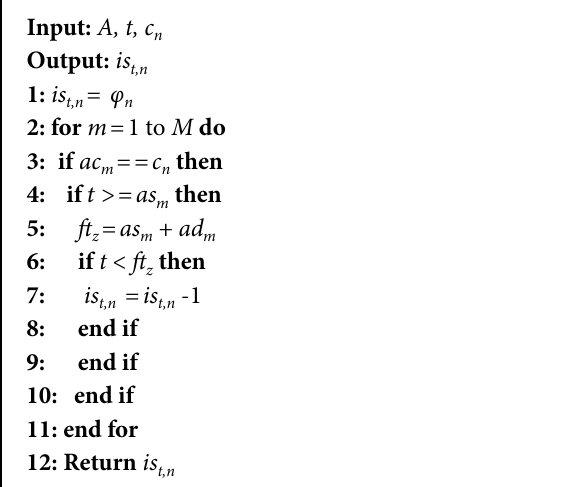
Algorithm 1: Edge server idle space